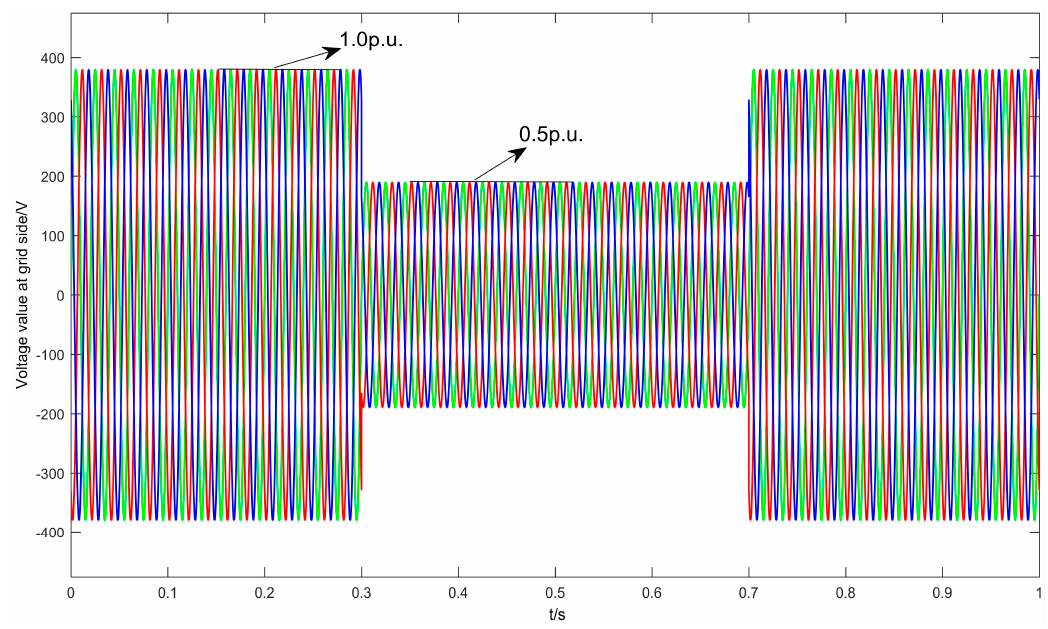
Figure 13. Balance drop of network measurement voltage.